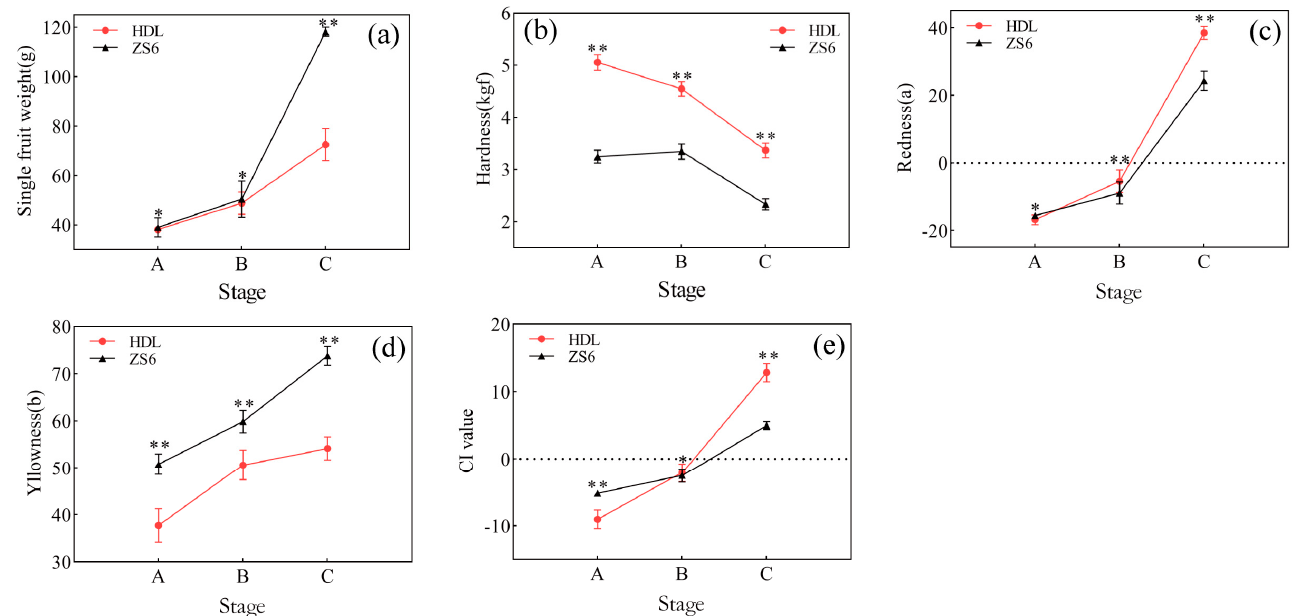
Figure 1. Basic phenotypic parameter changes between two persimmon cultivars during fruit development and maturation: ( a ) single-fruit weight, ( b ) hardness, ( c ) redness, ( d ) yellowness, and ( e ) CI value. A significant difference between the two persimmon cultivars at the 0.05 or 0.01 level throughout the same period is shown by the letters * or **, respectively. A, B and C on the abscissa represent stage A, stage B and stage C respectively during fruit development. ZS6 and HDL represent Zhongshi No. 6 and Hongdenglong. The same applies below.